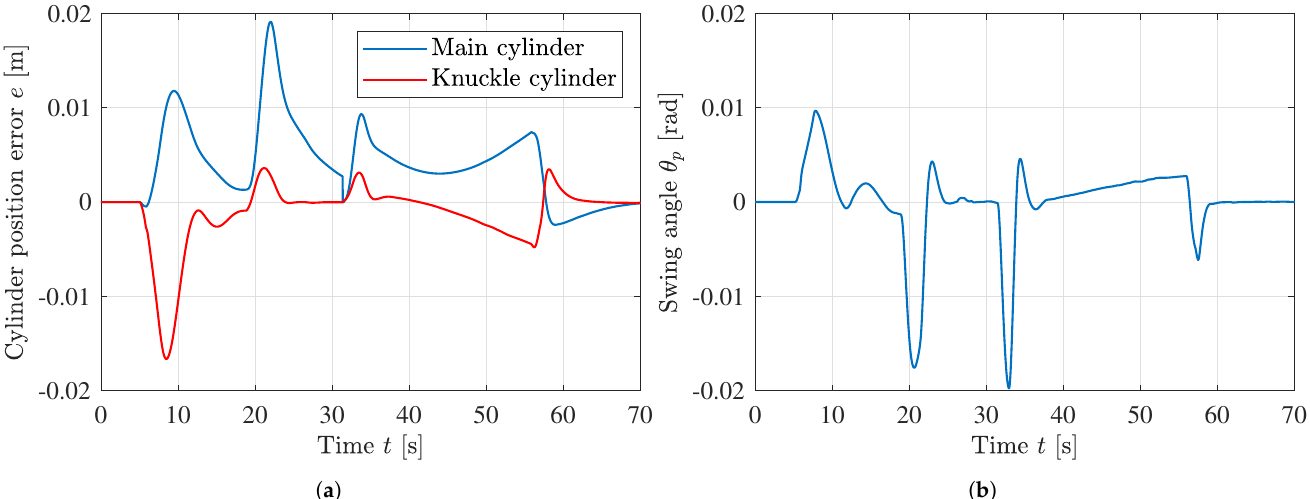
Figure 31. Cylinder position error and swing angle during motion with valve-controlled actuators. ( a ) Cylinder position error; ( b ) Swing